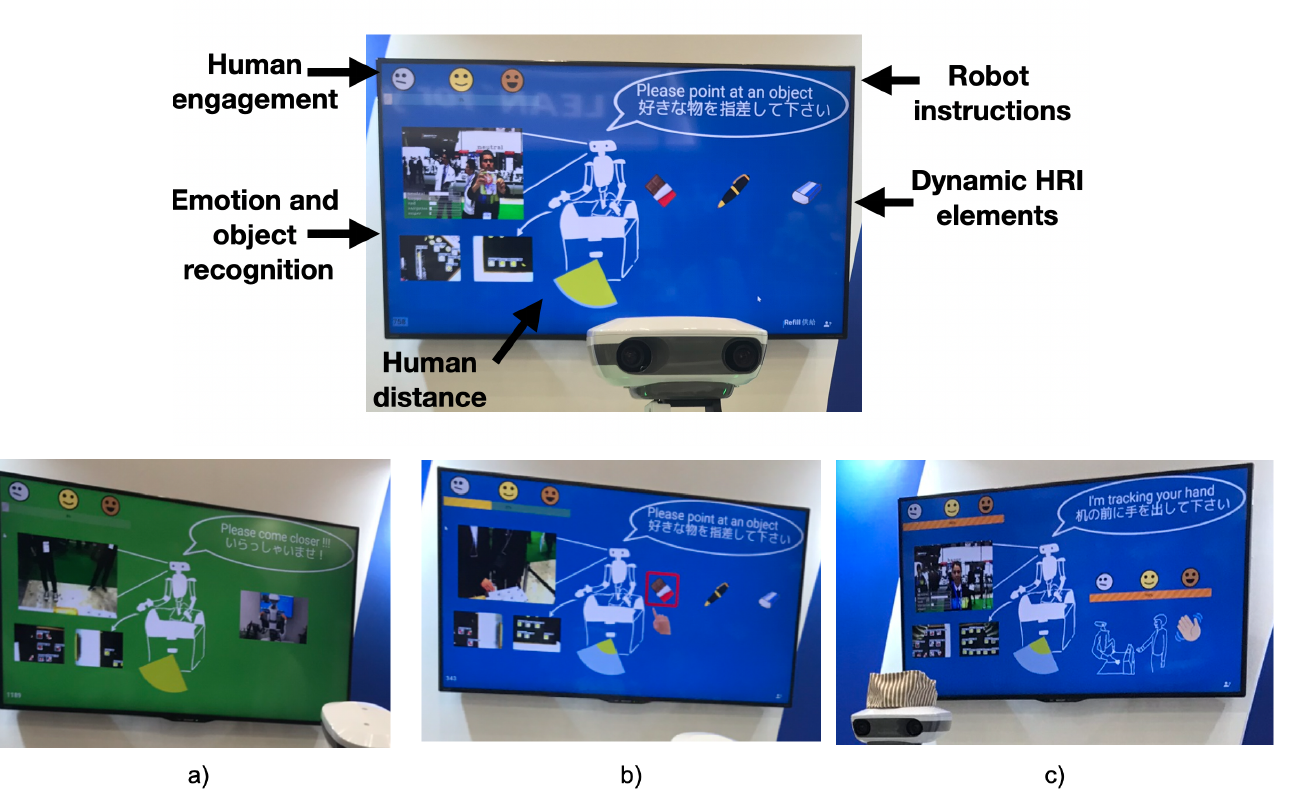
Figure 2. Top : main elements of the designed Graphical User Interface (GUI). Bottom: examples of elements shown in the GUI according to the status of the interaction: ( a ) No human interaction is performed, ( b ) the interface shows which object is selected by the human, ( c ) the robot provides information about what it is doing and how it